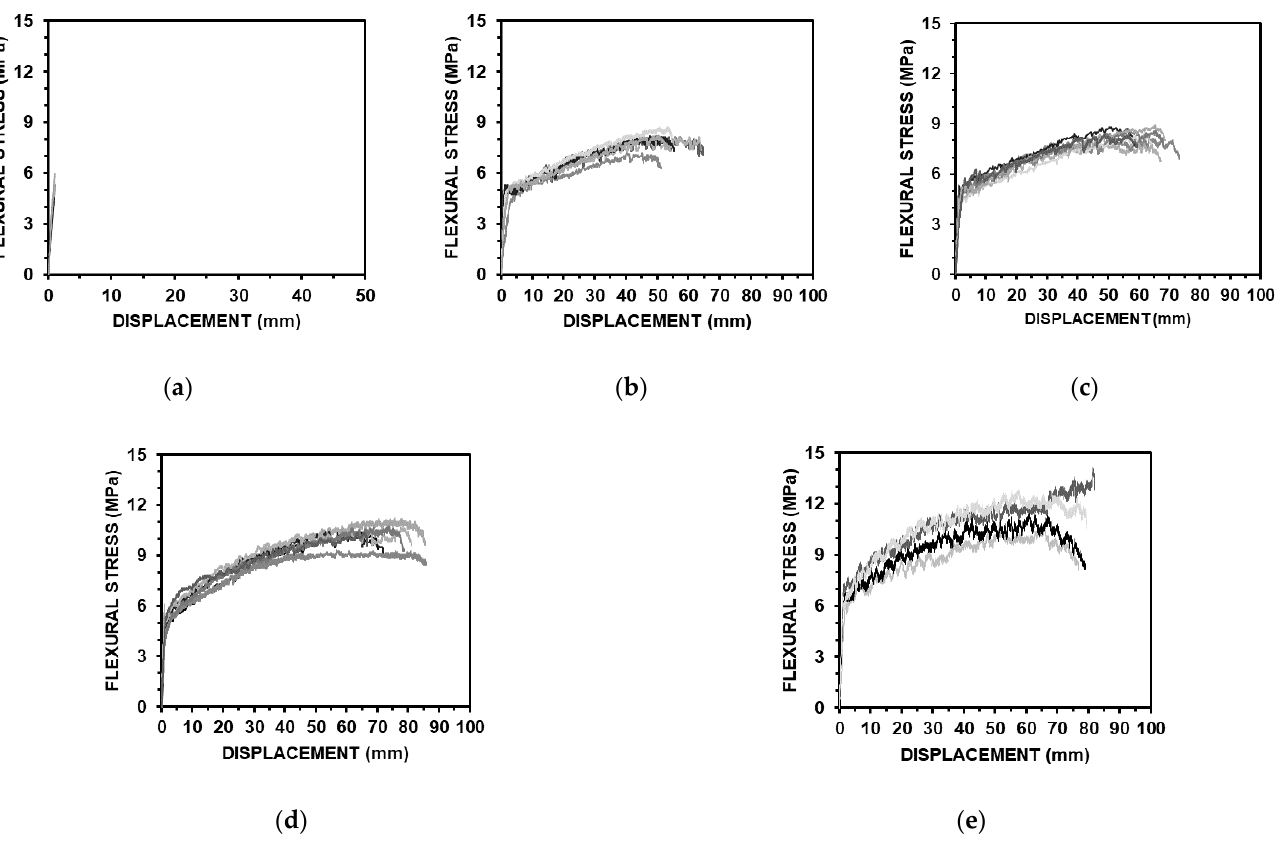
Figure 9. Flexural stress – displacement curves: ( a ) ASFC000 (PVA 0.00 vol.%); ( b ) ASFC100 (PVA 1.00 vol.%); ( c ) ASFC125 (PVA 1.25 vol.%); ( d ) ASFC150 (PVA 1.50 vol.%); ( e ) ASFC200 (PVA 2.00 vol.%).